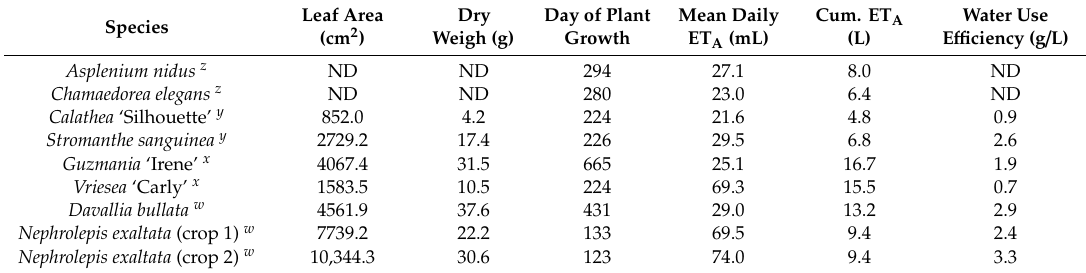
Table 3. Summary of leaf area, dry weight, day of plant growth, mean daily ET A , cumulative ET A , and water use e ffi ciency of eight foliage plant species produced from liners to marketable sizes in the same location. Leaf Area Dry Day of Plant Mean Daily Cum. ET A Water Use Species (cm 2 ) Weigh (g) Growth ET A (mL) (L) E ffi ciency (g / L) Asplenium nidus z ND ND